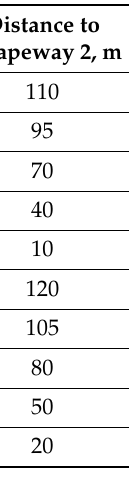
Figure 8. Fire situation on the first floor. Table 3. Information for each zone.